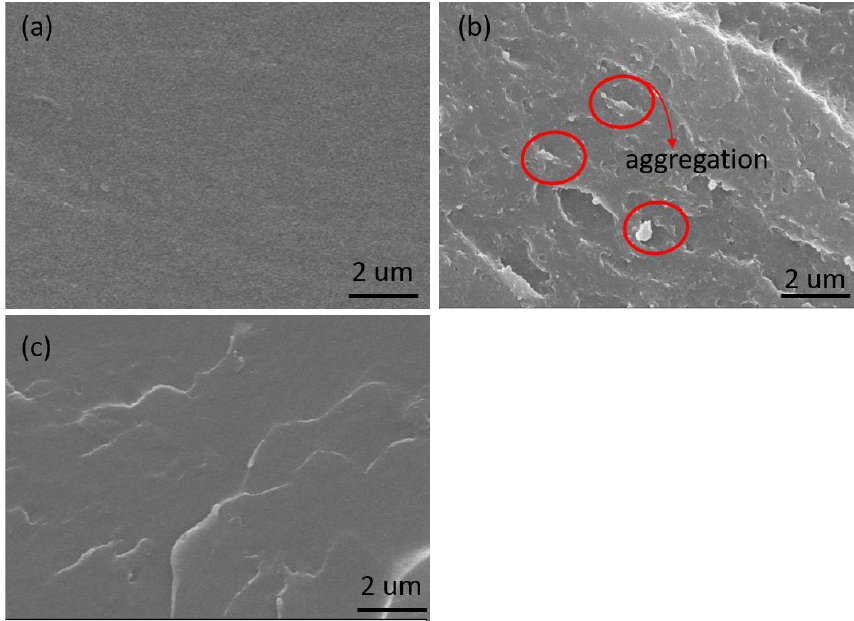
Figure 6. SEM images of the fracture surface of neat waterborne epoxy coating (WEP) ( a ); MoS 2 /WEP ( b ); MoS 2 -APTES/WEP ( c ). ( b ); MoS 2 -APTES/WEP ( c